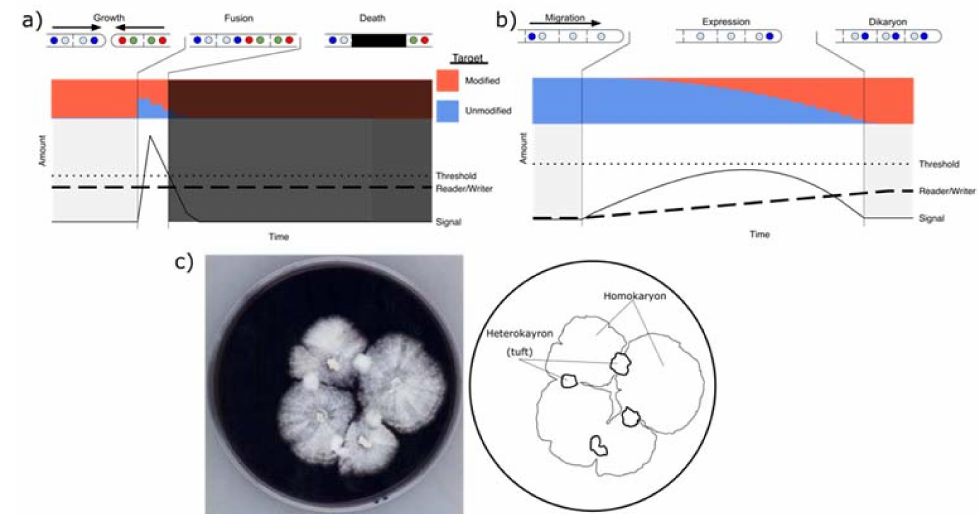
Figure 4. Dynamics of a reader/writer system during hyphal fusion, cytoplasmic mixing, and mating. ( a ) Graph of dynamics of any fusion involving cytoplasmic mixing, in this case between heterokaryotic basidiomycete mycelium. Dotted line shows the threshold above which cell death is triggered. Dark dashed line shows the concentration of the reader/writer of the newly resident blue nucleus. Solid line indicates the signal produced by the activity of the reader, which produces a signal proportional to the amount of unmodified target protein (Blue in the graph above). In this example, the reader has an activity five times higher than the writing activity, and the signal does not rise above the threshold. In this case, the high concentration of reader/writer protein immediately raises the signal above the threshold for cell death, based on the presence of unmodified target protein; ( b ) dynamics of the tip cell of a homokaryon during fertilization; ( c ) Mating reaction in Agaricus bisporus , a species with little nuclear migration, showing the relatively limited production of heterokaryons (“tufts”) in the interaction zone between homokaryons. (photo credit: Mushroom Group,